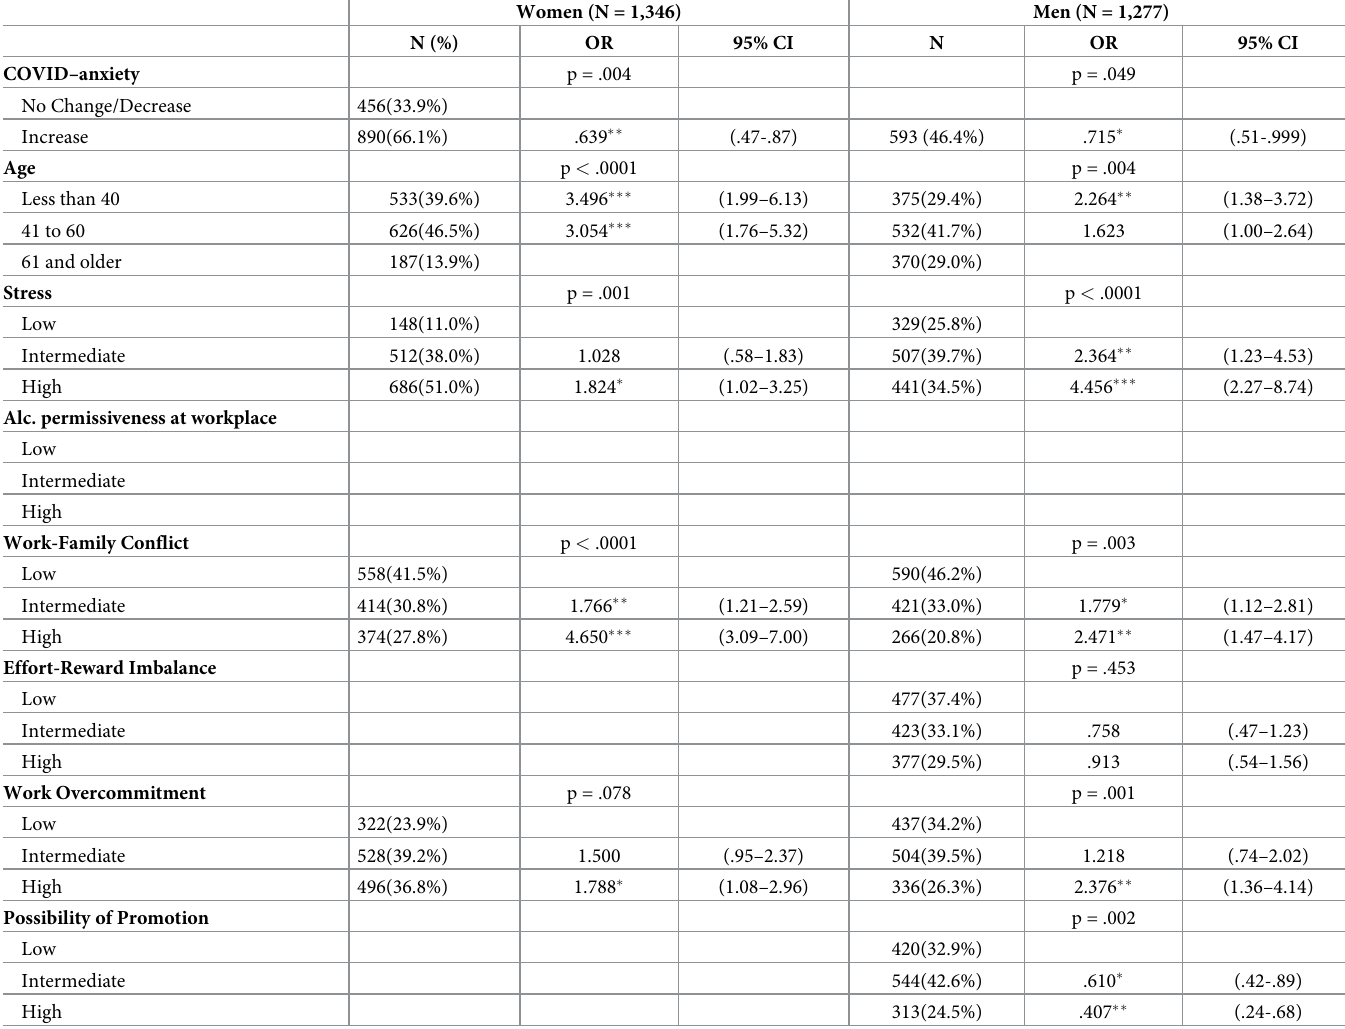
Table 6. Work-related predictors of leaving or contemplating leaving the legal